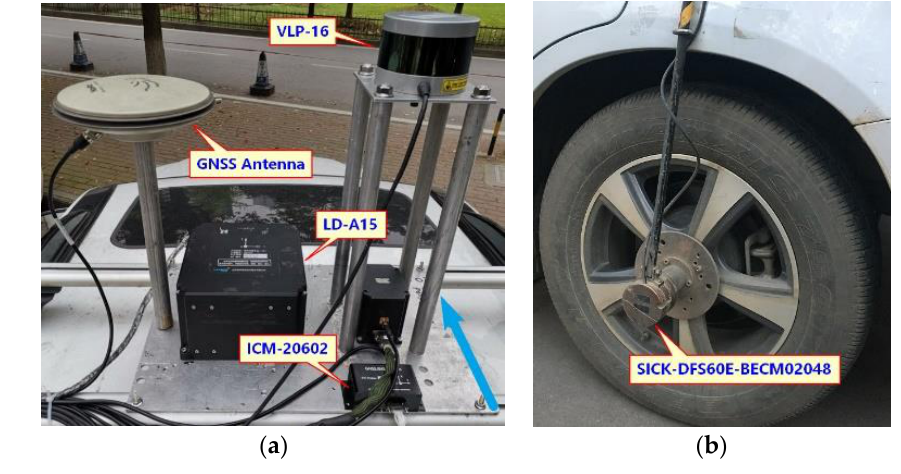
Table 1. Specifications of the LD-A15 and ICM-20602.